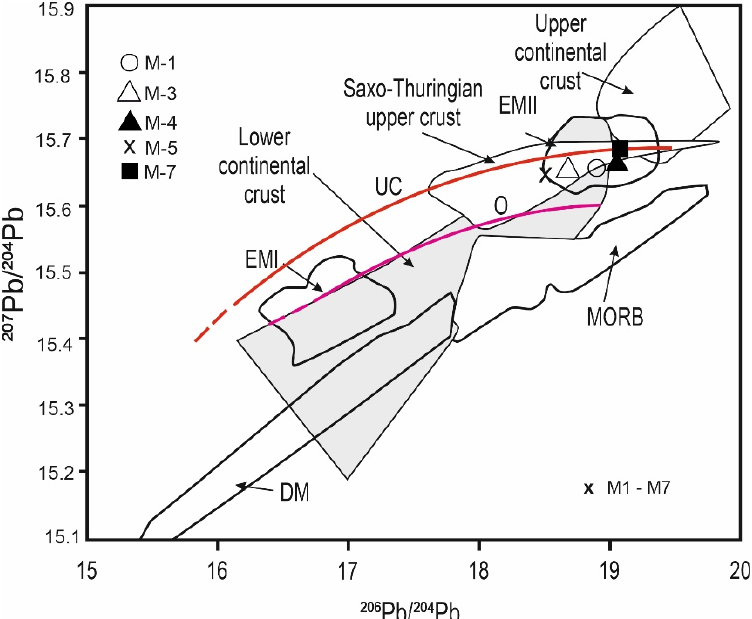
Figure 13. 207Pb/204Pb vs. 206Pb/204Pb in studied basalt; Saxo-Thuringian upper crust are taken from Romer and Hahne [68] and DM, EMI, EMII (from Zindler and Hart [63].Orogene (O) and upper crust (UC) Pb evolution curves are after Zartman and Doe [69].Other fields from Sommer et al. [70]; Sample M-1—M7 from Table